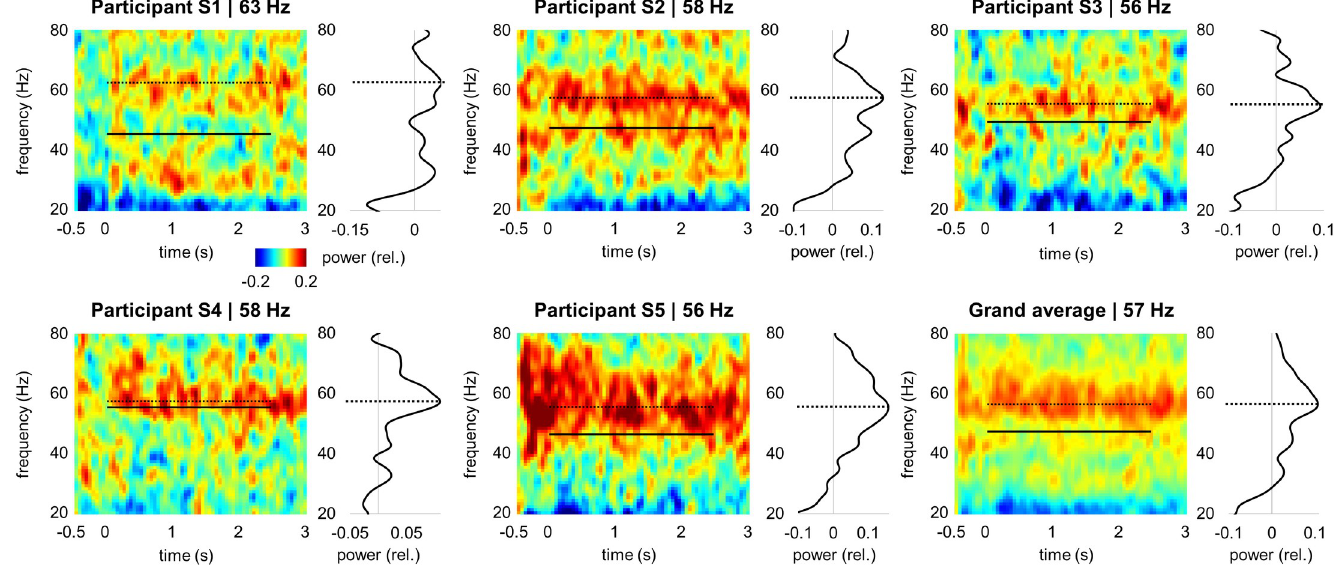
Fig 3. Time-frequency representation of the power (relative change) induced by the gratings. The dashed line indicates frequency of the induced gamma oscillations, and for comparison, the solid line indicates frequency of the gamma echo. Curves next to the time-frequency plots represent power averaged over the -0.5 to 3 s time